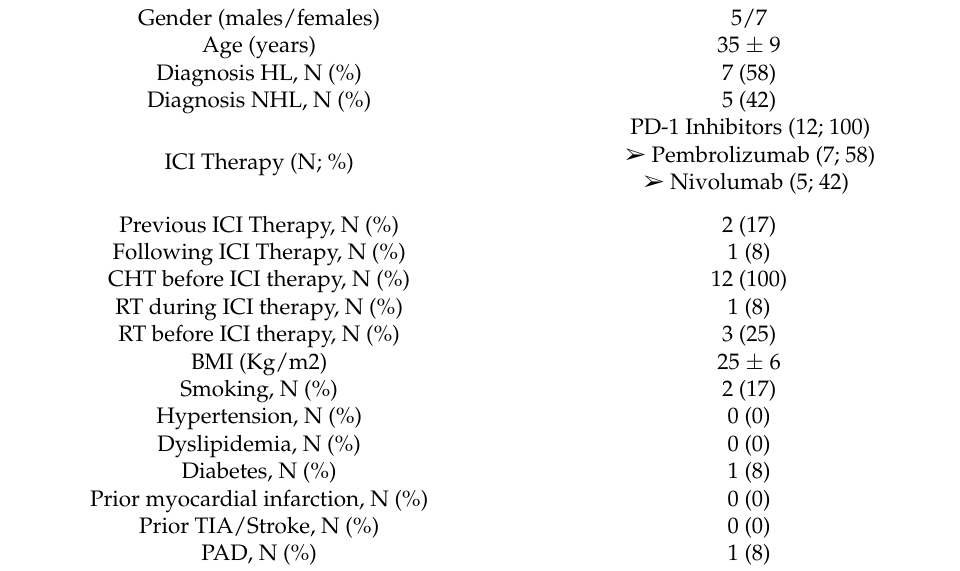
Table 1. Baseline patient characteristics. General features of the patient population. Gender (males/females)